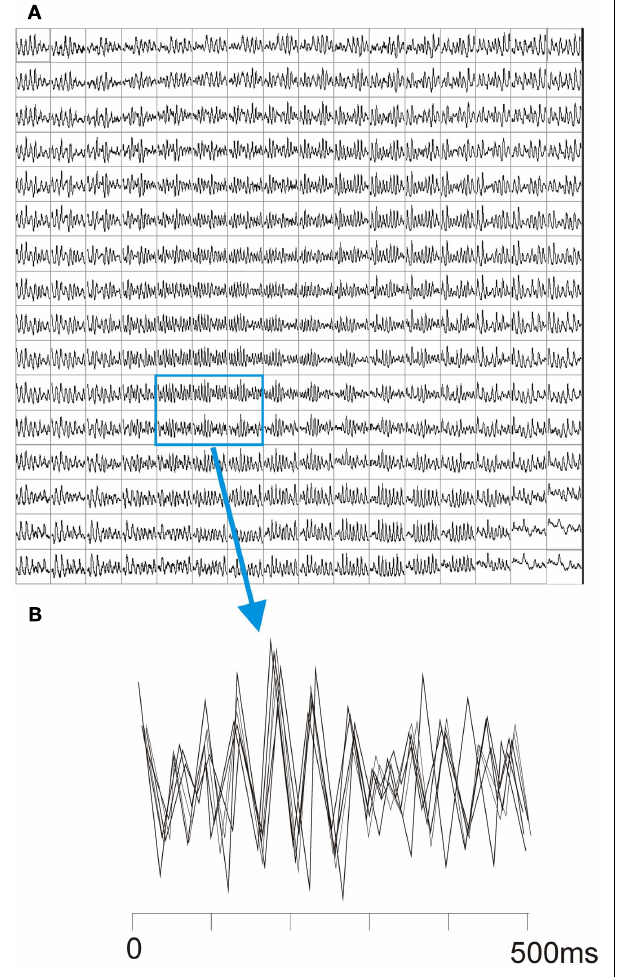
FIGURE 2 | Optical traces duringVF and assessment of coordination. (A) Shows typical optical traces by the PDA duringVF. (B) Shows overlaying of six adjacent signals from the highlighted area.The signals are superimposed with time off-set to allow maximum cross-correlation.